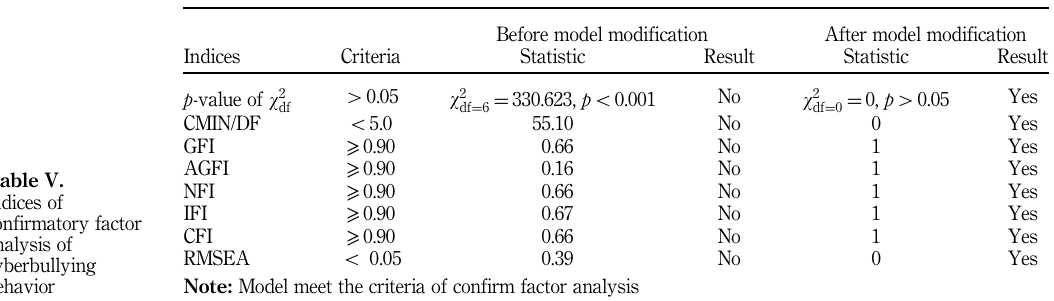
Before model modification